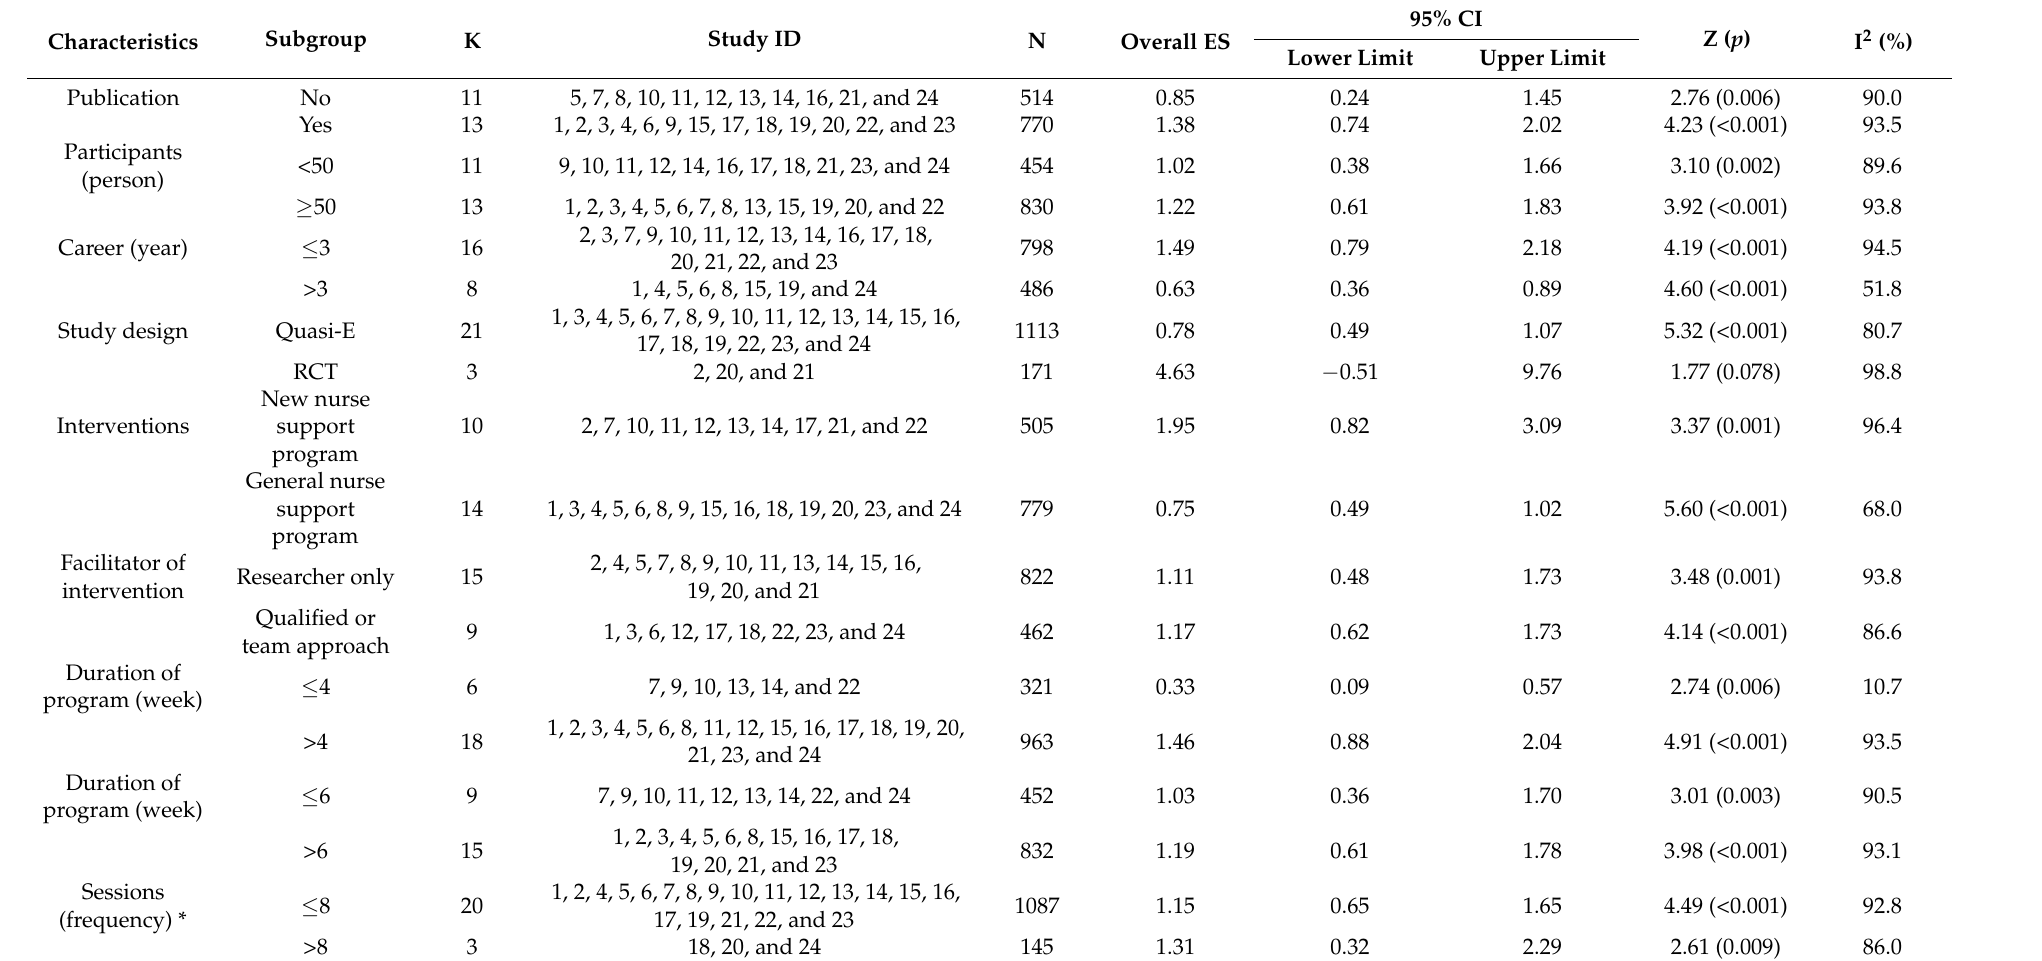
Table 4. Subgroup analysis regarding job satisfaction by study